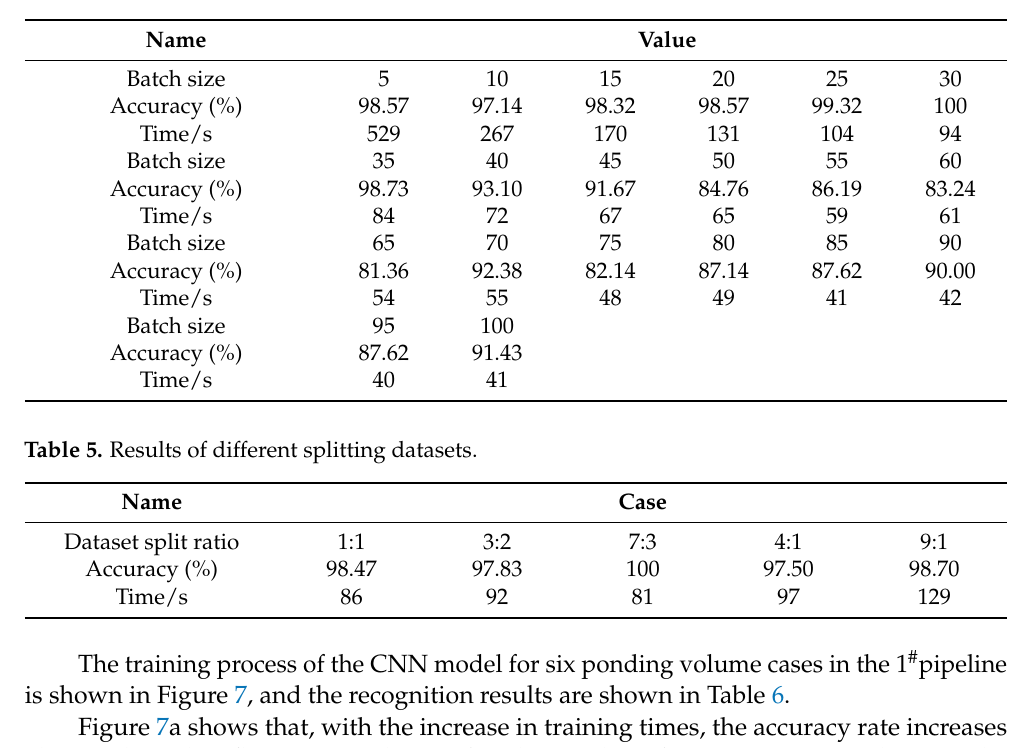
Table 5. Results of different splitting datasets.